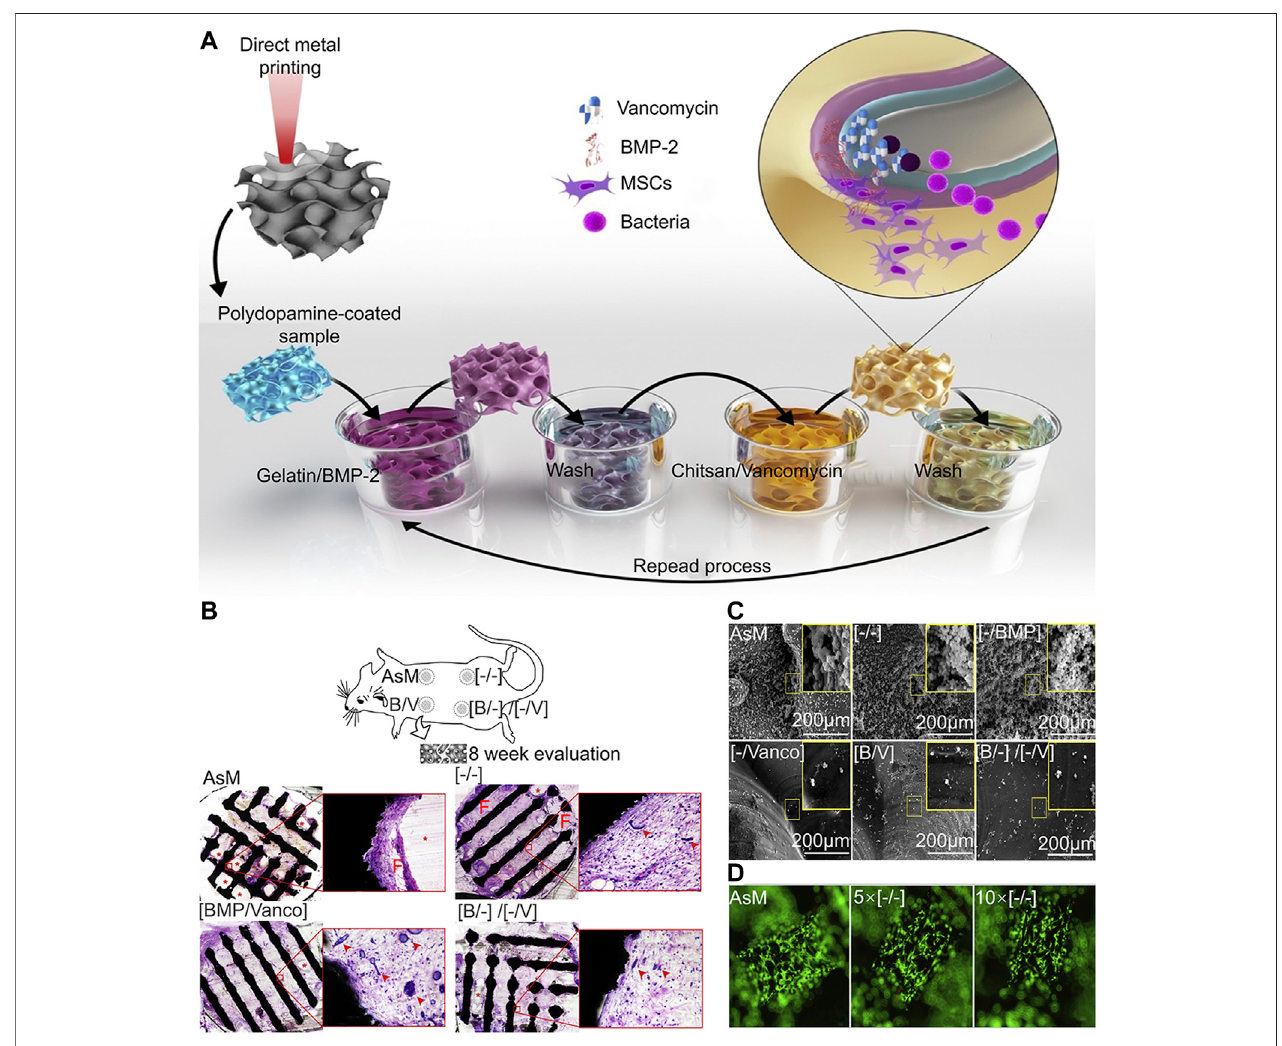
FIGURE 3 | LBL vancomycin and BMP-2-coated implants (Amin Yavari et al., 2020). (A) Schematic illustration of the layer-by-layer coating process. (B) The biocompatibility ofthescaffold wasanalyzed 8weeksafter implantation,the porousTistructuresdid notinducean adverse tissue responseinany ofthegroups, shown by the absence of acute in fl ammation or fi brous encapsulation at the material-tissue interface. In the case of any LBL remnants, no acute in fl ammatory response was seen around the polymer. At the same time, we observed a high density of blood vessel formation. (C) Representative images of planktonic and adherent bacteria on the surfaces of different experimental groups. In the experimental group containing vancomycin, the number of bacteria was signi fi cantly less. (D) In the live death staining experiment, the surface of the implant was completely covered by living cells, and the surface coating had no inhibitory effect on cell adhesion and proliferation.